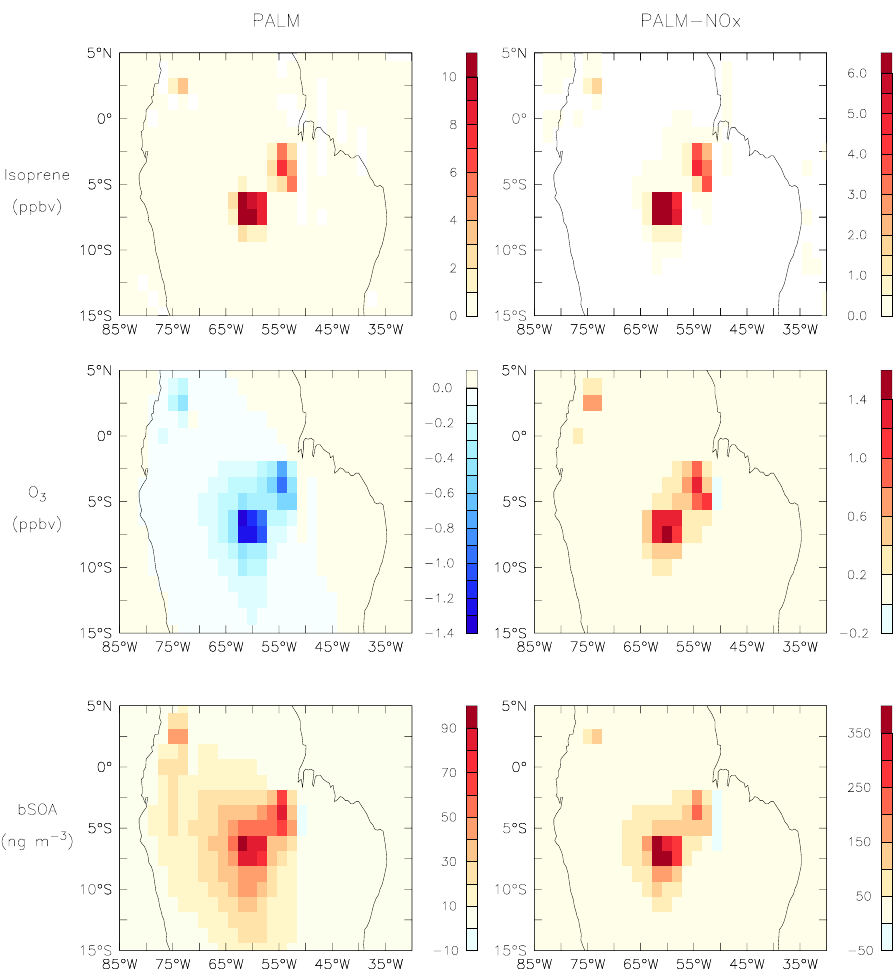
Fig. 2. Differences in annual mean surface concentrations of isoprene (top), ozone (middle) and SOA (bottom) for Amazonia for PALM vs. CTRL (left) and PALM NO x (right). Note change of scale from PALM to PALM NO x